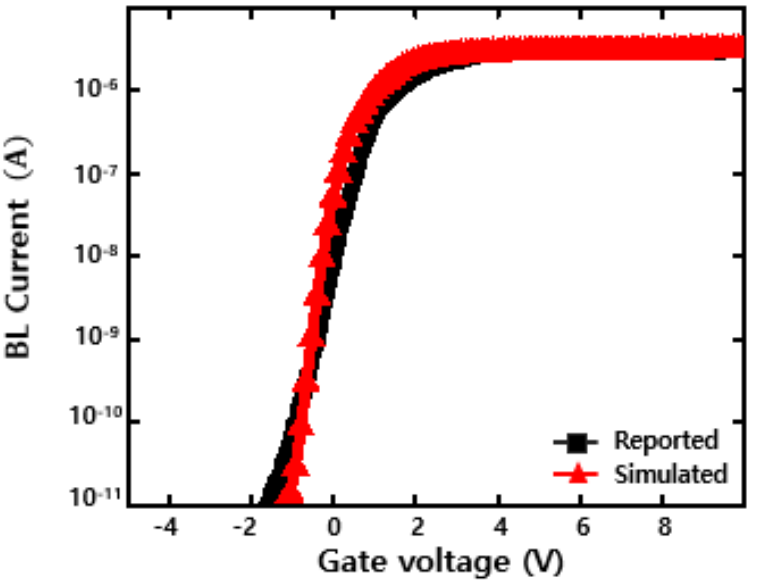
Figure 2. TCAD calibration with the reported experimental data. The residual stress of ( a ) the tungsten film after the tungsten replacement gate process and ( b ) the polysilicon channel in the final structure.